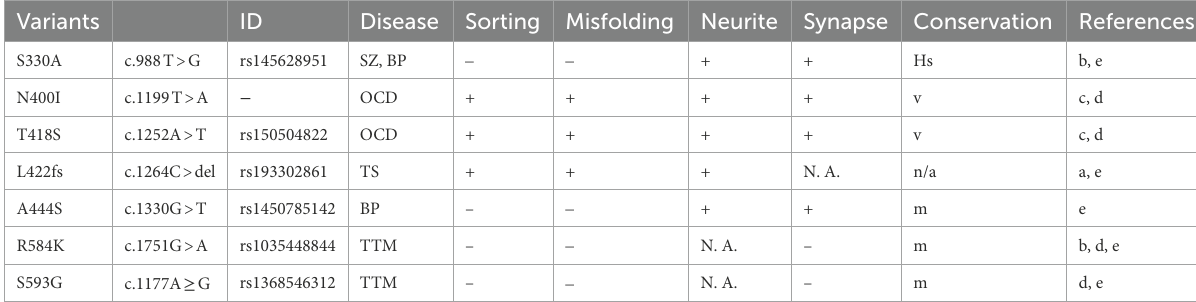
TABLE 1 SLITRK1 variants identified in the